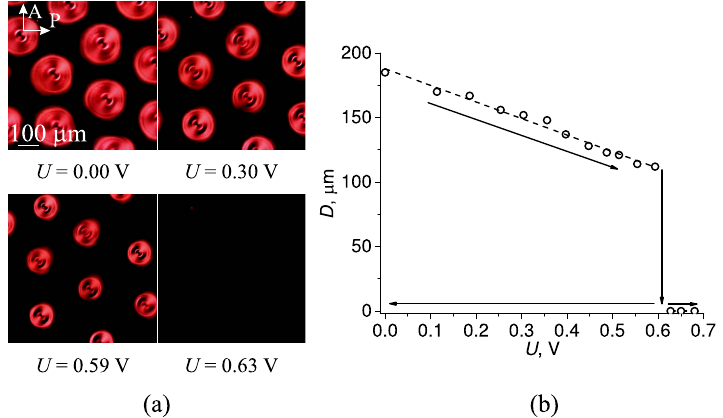
Figure 3. The particle-like structures formed during cooling from isotropic phase and the effect of applied electric field on the size of the axisymmetric structures ( a ); the dependence of the structure diameter D on the electric field voltage V ( b